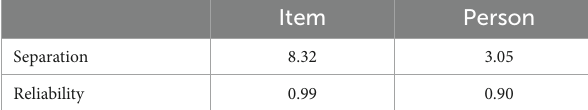
TABLE 5 Item- and person-level reliability and